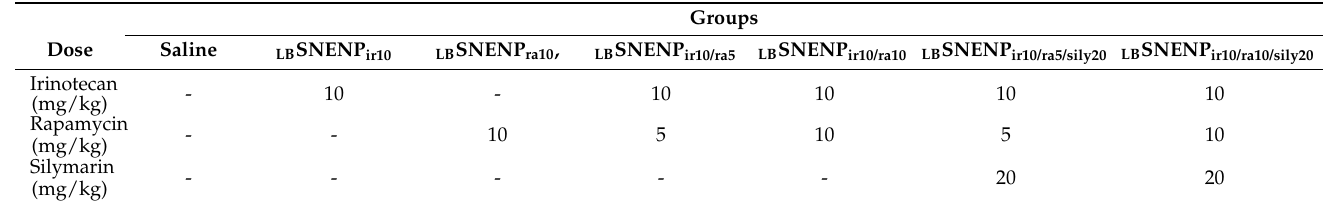
Table 4. The dose of irinotecan, rapamycin, and silymarin in each group of efficacy studies.